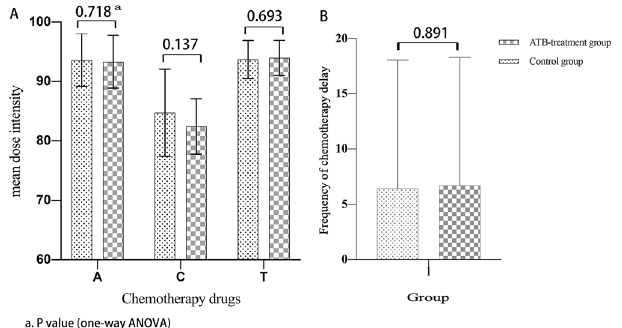
Figure 1. Comparison of dose intensity and frequency of dose delay. ( A ) The mean dose intensity. ( B ) frequency of dose